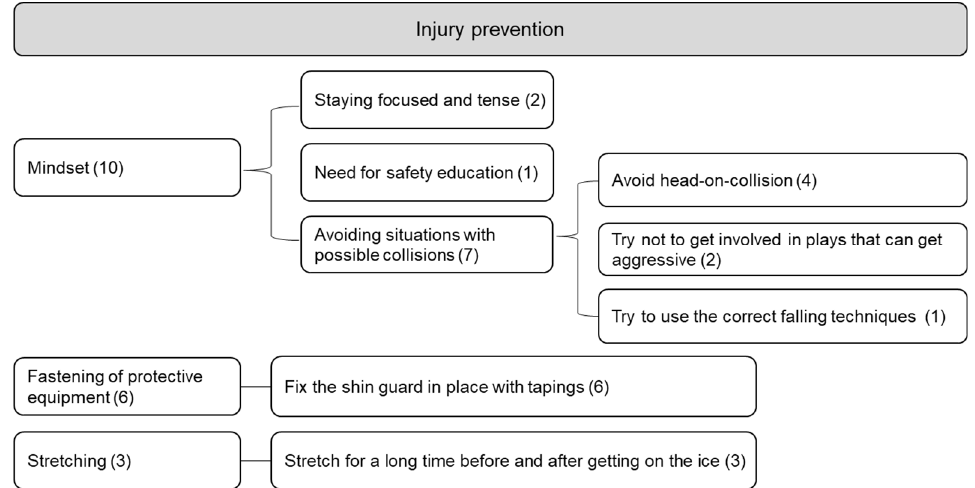
Figure 3. Prevent injuries (coding number in parenthesis).